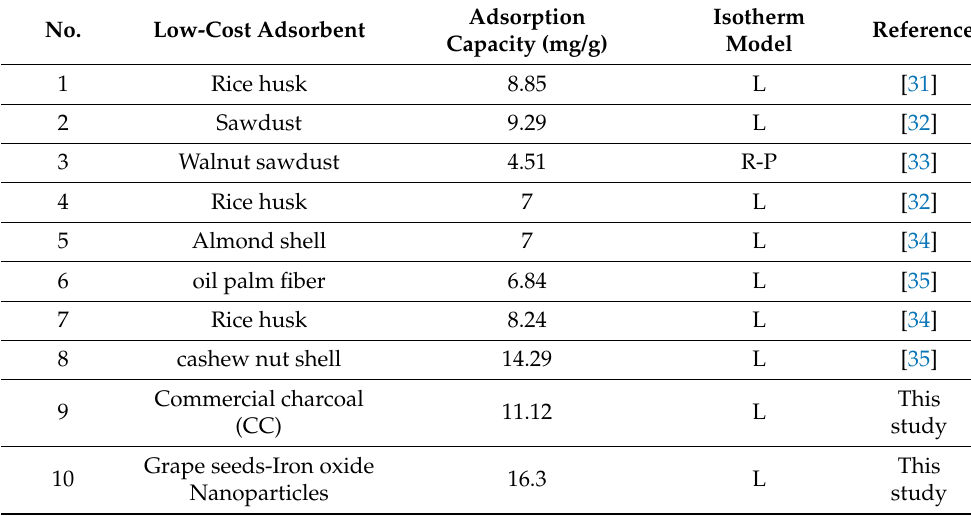
Figure 7. Adsorption capacity of Cd onto GS-IONPs in various contact durations. Skwarek and Janusz [29] reported on the a dsorption of Cd(II) ions at the hydroxyapatite/electrolyte solution interface and the changes of the electrical double layer (EDL) structure in this system are presented. The adsorption of Cd(II) ions was calculated from the loss of their concen- tration from the solution using the radioisotope method. The adsorption was studied in the range of the initial concentra- tion from 0.000001 to 0.001 mol/dm 3 and as the function of pH [29]. Table 4. Summary of cadmium adsorption capacities of various